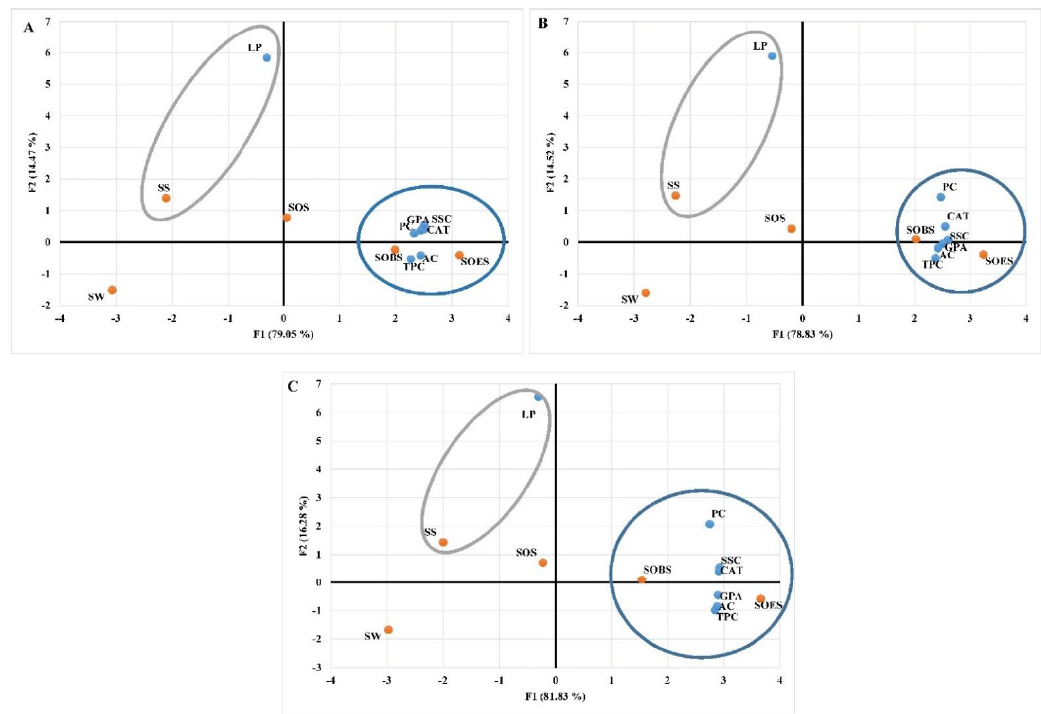
Figure 2. PCA plot illustrating the distribution of leaf biochemical characteristics and treatments under first ( A ), second ( B ), and both ( C ) stress circumstances. PC: proline content, SSC: soluble sugar content, TPC: total phenolic content, AC: antioxidant activity, LP: lipid peroxidation, GPA: peroxi- dase, CAT: catalase, SS: stressed plants that had not been treated, SOS: stressed plants that had been treated with oak leaf powder, SOES: stressed plants that had been treated with oak leaf powder and oak leaf extract, SOBS: stressed plants that had been treated with oak leaf powder and biofertilizers. F1 and F2 represent the first and second components,